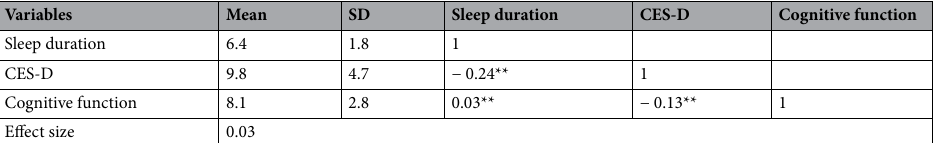
Table 2. correlation matrix (n = 12,589). SD standard deviation, CES-D the Center for Epidemiologic Studies Depression Scale. All the analysis controlled for age, gender, education, marital status, residency, smoking, drinking, BMI, hypertension, dyslipidemia, and diabetes or high blood sugar. **p < 0.01, *p < 0.05.